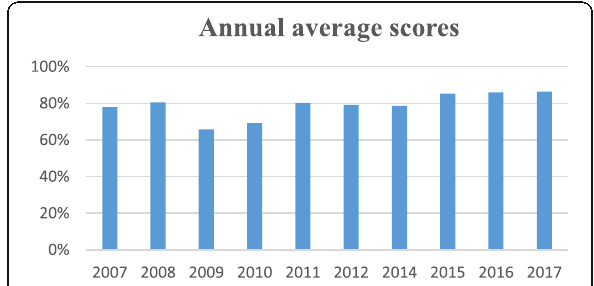
Fig. 2 Trainee average scores in the annual biosafety level 3 training